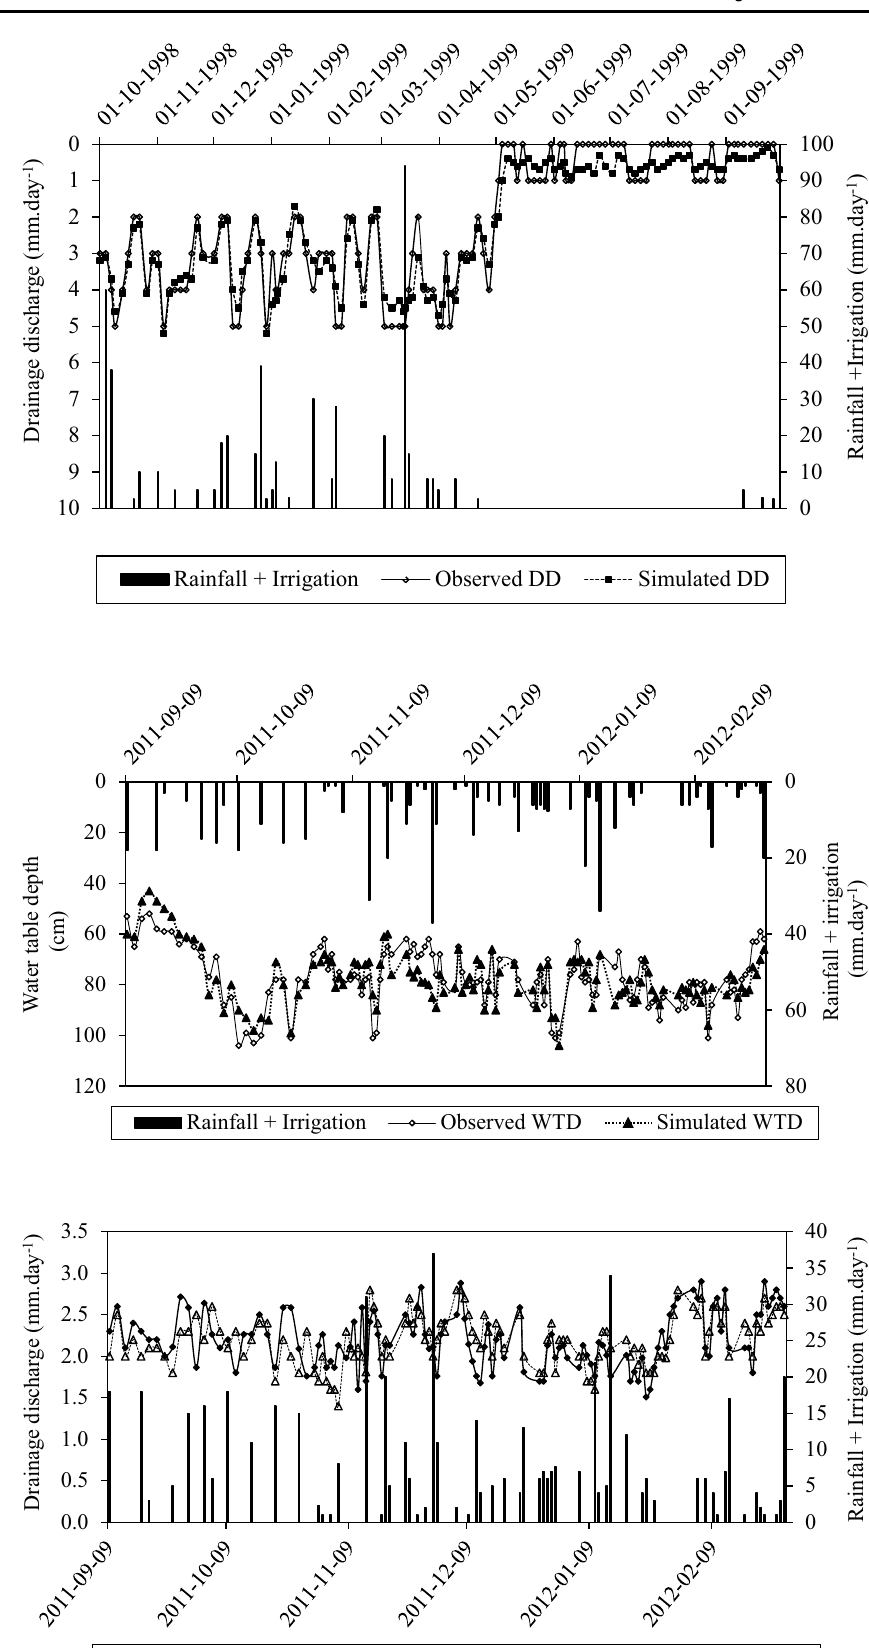
Fig. 5 Drainage discharge fluctuation the during calibra- tion period